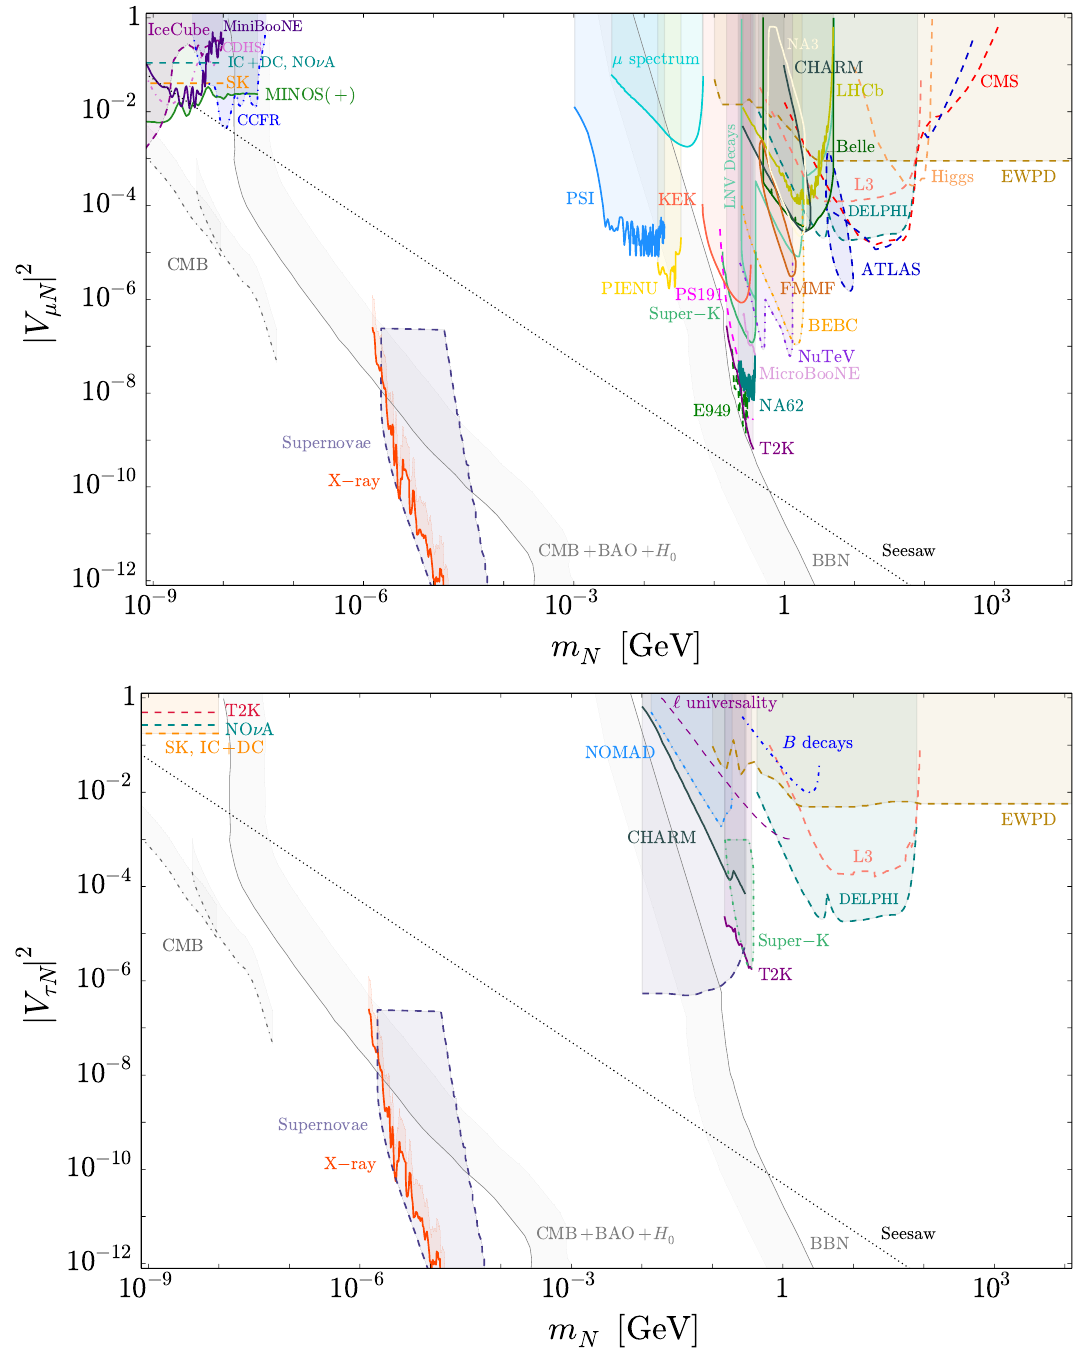
2 V (cid:22)N j j